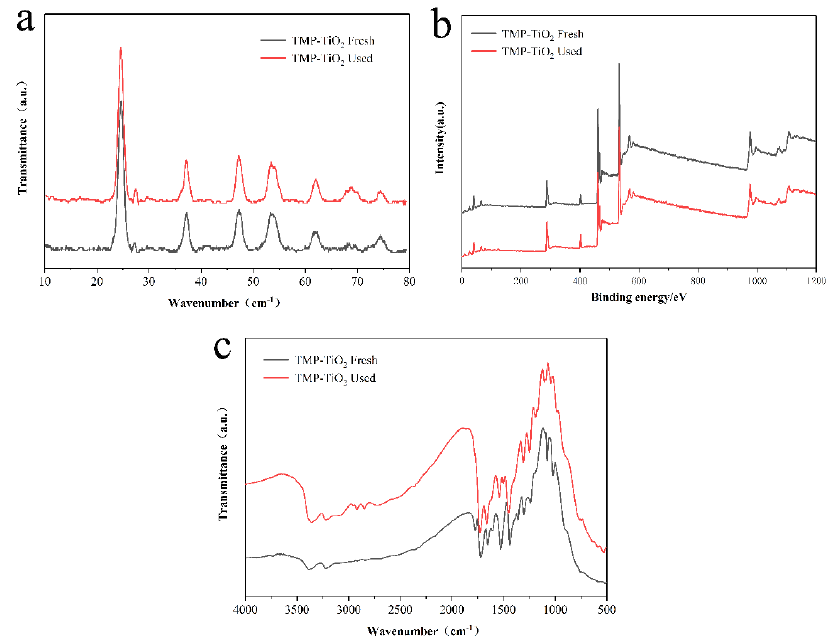
Figure 11. ( a ) XRD spectra of TMP-TiO 2 before and after photocatalytic reaction, ( b ) XPspectra of TMP-TiO 2 before and after photocatalytic reaction, and ( c ) FTIR of TMP-TiO 2 before and after photocatalytic reaction.